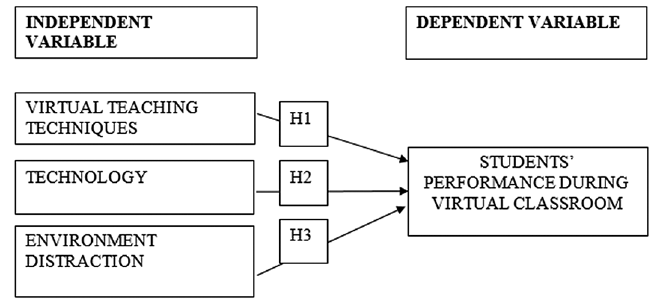
Figure 1. The research